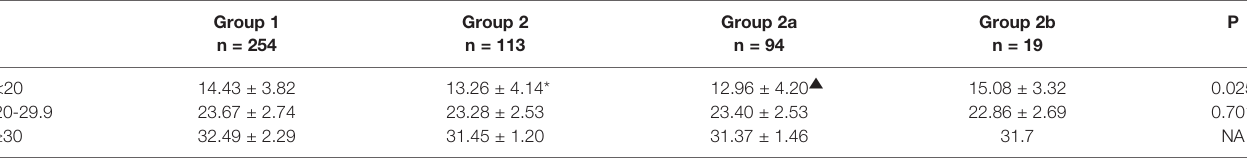
Data are expressed as mean ± SD, median (interquartile range). Group 1, patients with type 2 diabetes and normal testosterone levels; Group 2, patients with type 2 diabetes and hypogonadism; Group 2a, patients with type 2 diabetes and hypogonadotropic hypogonadism; Group 2b, patients with type 2 diabetes and hypergonadotropic hypogonadism. P value represents statistically signi fi cant difference between Group 1, Group 2a and Group 2b (ANOVA). *P < 0.05, Group 1 vs. Group 2; ▲ P < 0.05, Group 1 vs. Group 2a (t-test or rank-sum test). NA, not